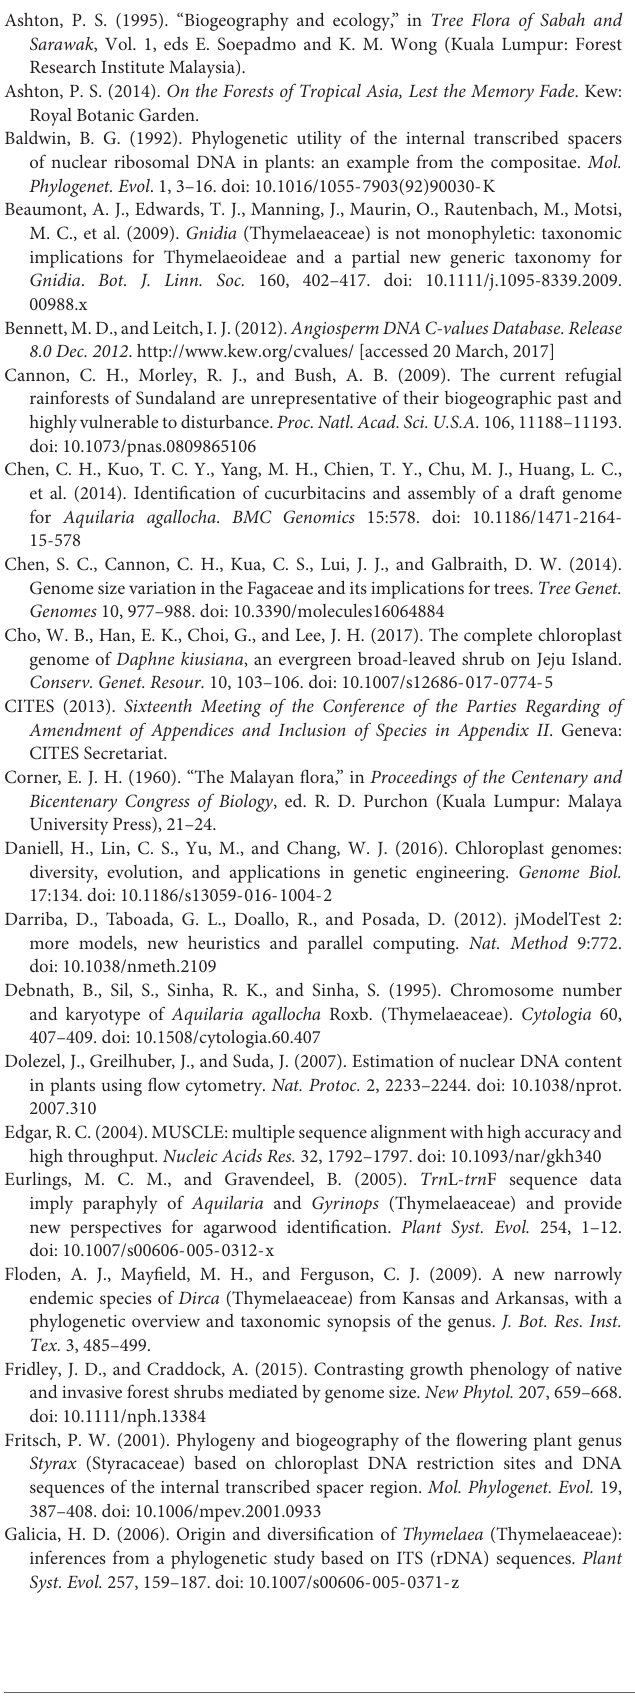
Frontiers in Plant Science |